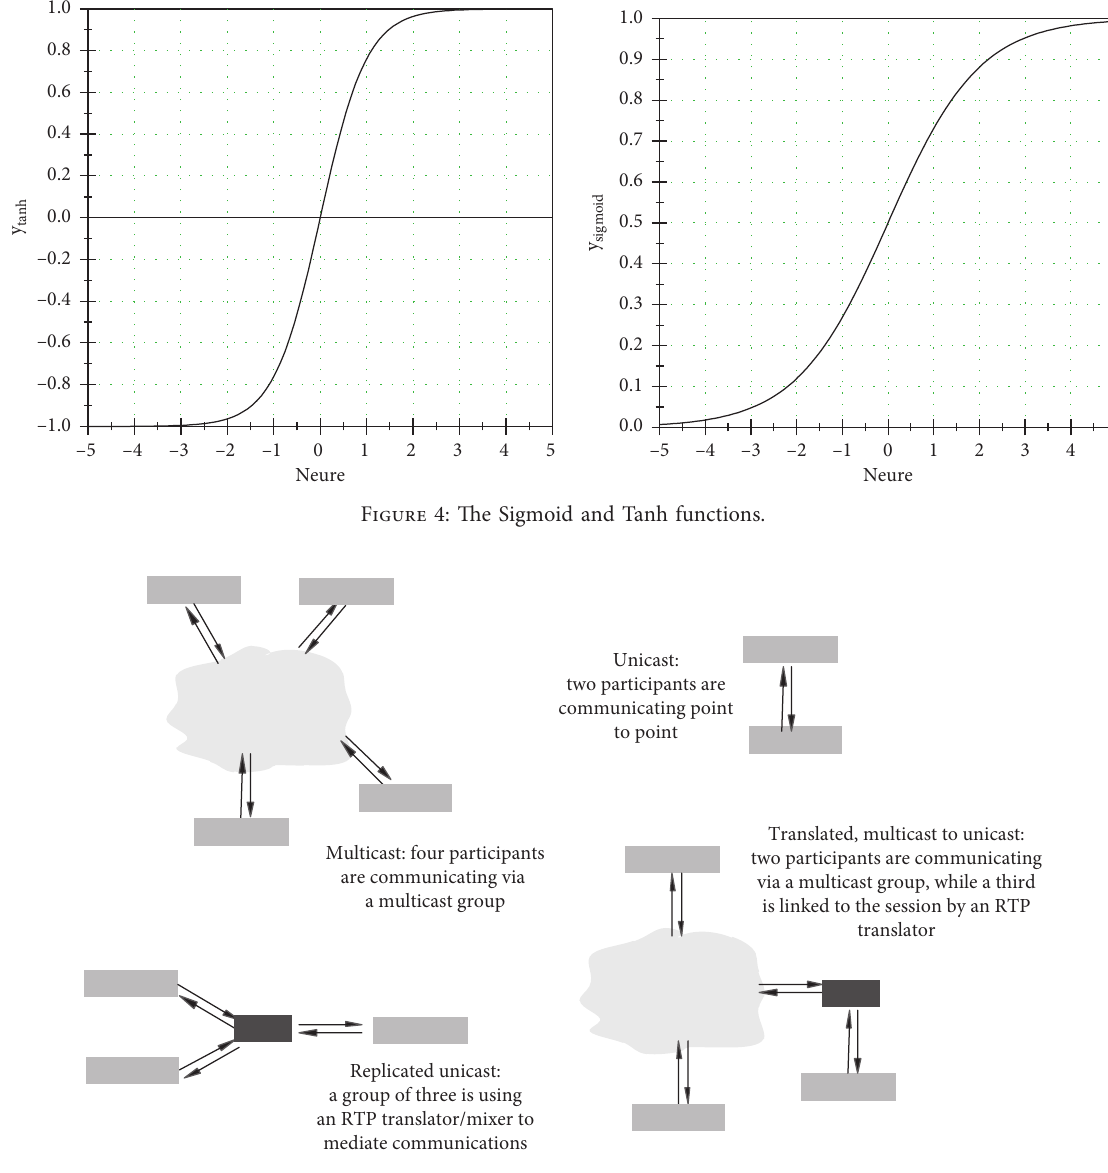
Figure 5: The report of RTCP.